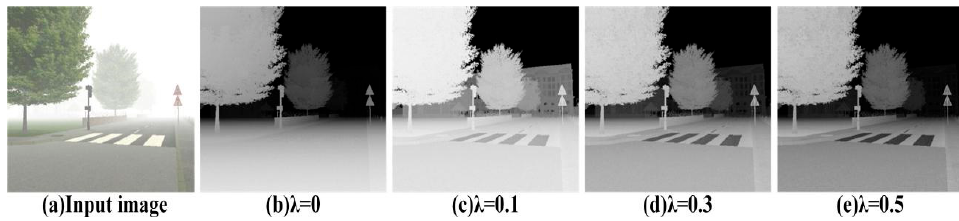
Figure 7. the structure feature maps with different λ .